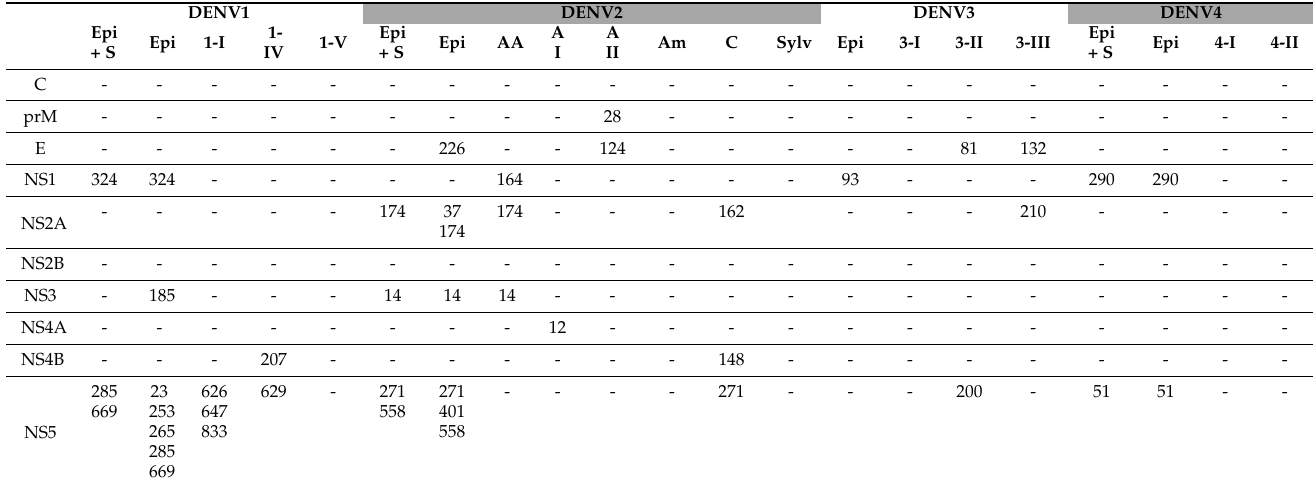
Table 2. Amino acid sites identified to be undergoing pervasive positive selection for DENV1,